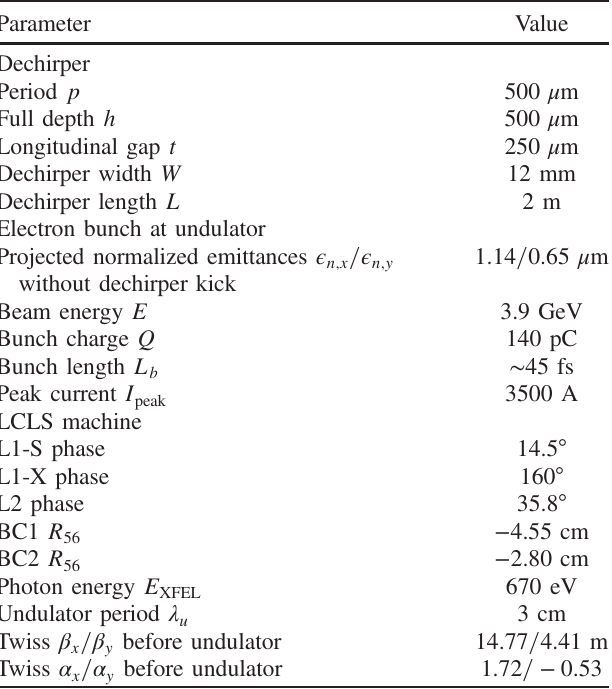
TABLE I. Main parameters used in